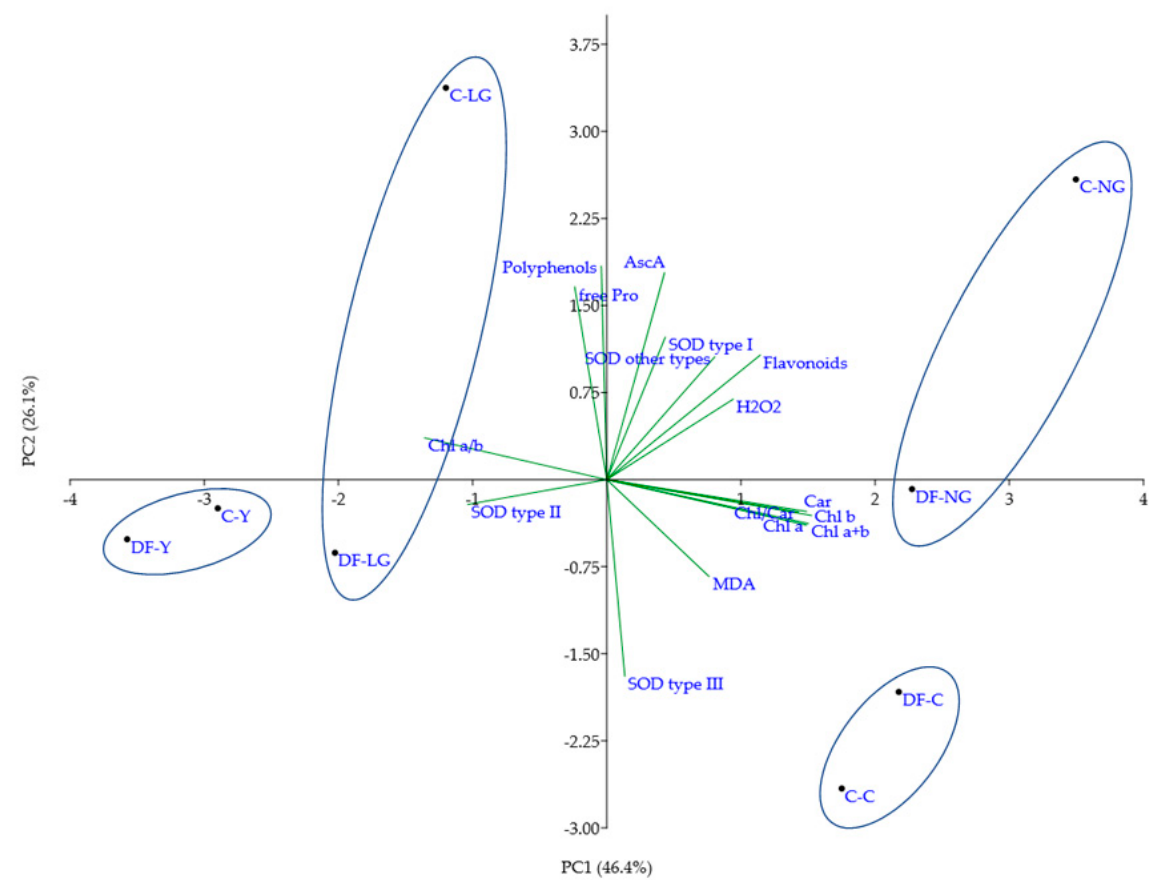
Figure 5. Biplot representing the first two principal components (PCs) (accumulating 72.5% of variance) generated using all tested biochemical parameters (ROS generation, antioxidants, and photosynthetic pigments). Ellipses enclose the same treatment and phenotypic groups of V. faba plants grown in control and polluted soils. Phenotypes of morphoses: NG—normal green, LG—light green, Y—yellow; C—plants grown in control soil; DF—plants from soil collected from different sites of the drill factory.